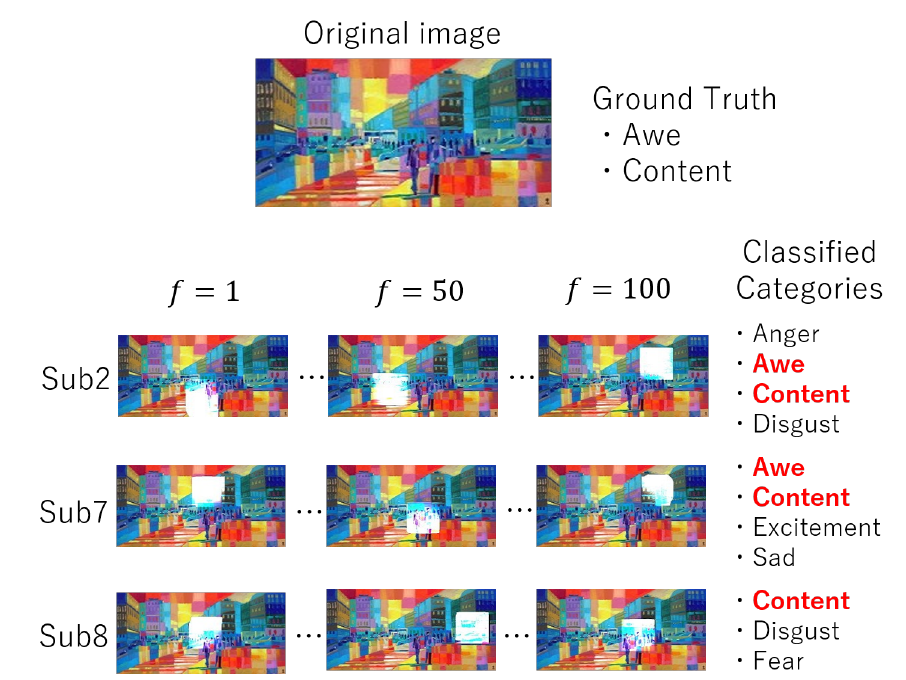
Figure 3. This figure shows some experimental results of some test images and their ground truths. The areas that the subjects gazed at are shown in white at frames 1, 50, and 100. From these gaze data, PM (D-I-X) classifies this image into some categories. If the classified category is the same as the ground truth, the corresponding category is indicated in red. If the classified category is false, the corresponding category is indicated in